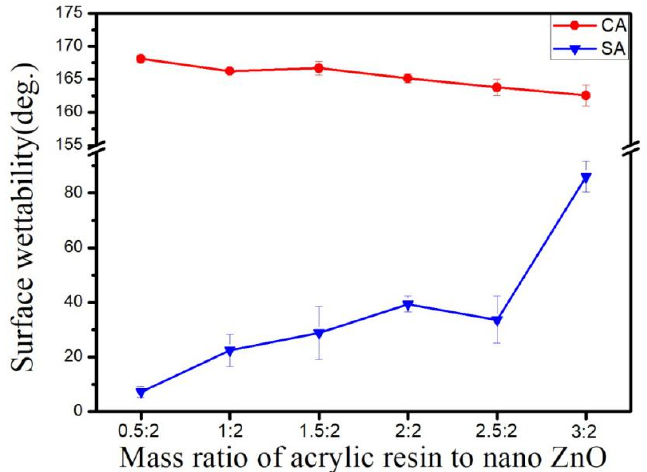
Figure 11. Sample wettability of different acrylic resin-to-ZnO mass ratio.